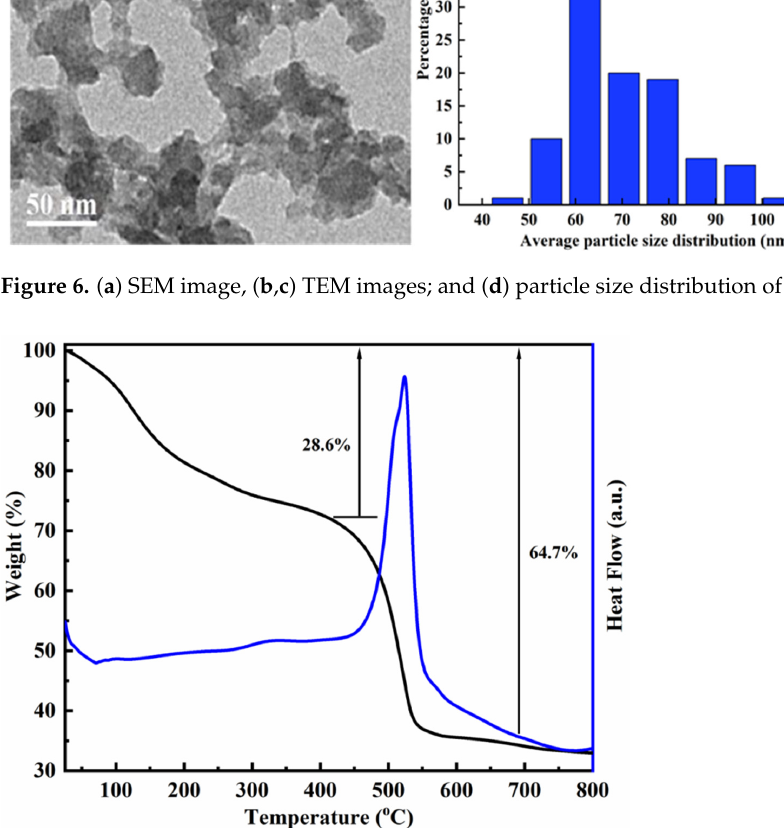
Figure 7. TG-DTA curves of